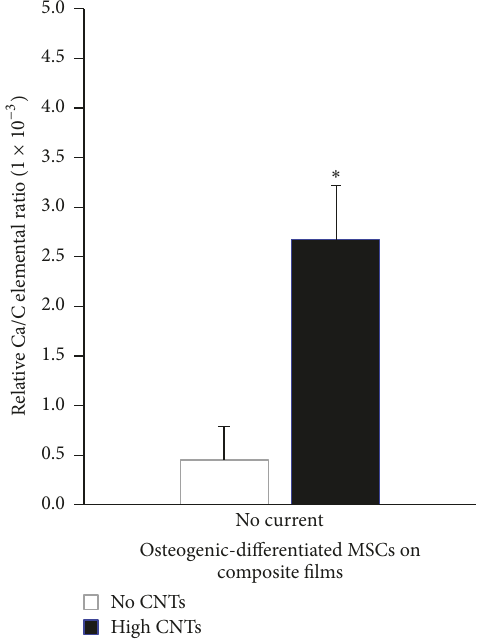
Figure8:RelativeamountsofCatoConinducedMSCsonsilicone- collagen substrates with high CNTs and no CNTs. ∗ 𝑝 < 0.05 for high CNTs versus no